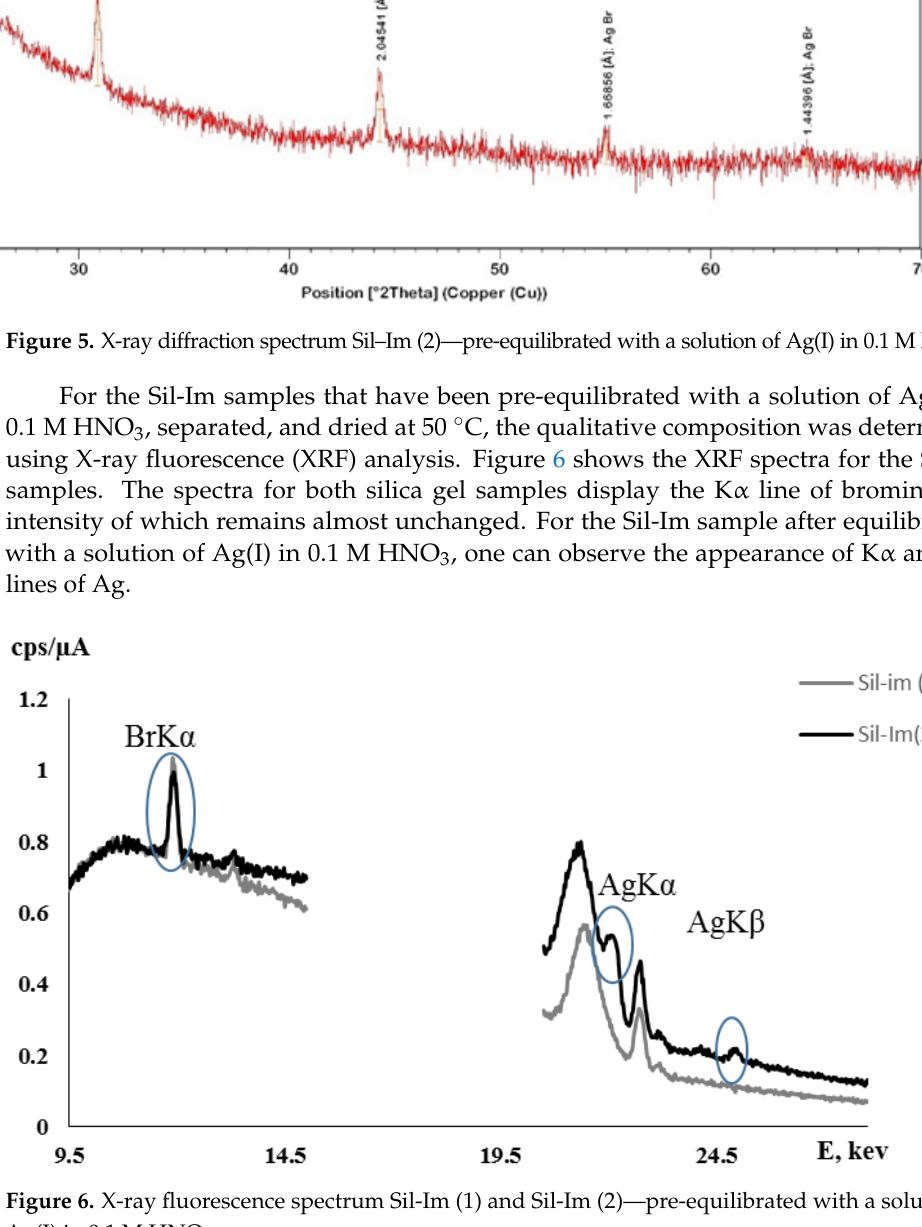
Figure 5. X-ray diffraction spectrum Sil – Im (2) — pre-equilibrated with a solution of Ag(I) in 0.1 M HNO 3.